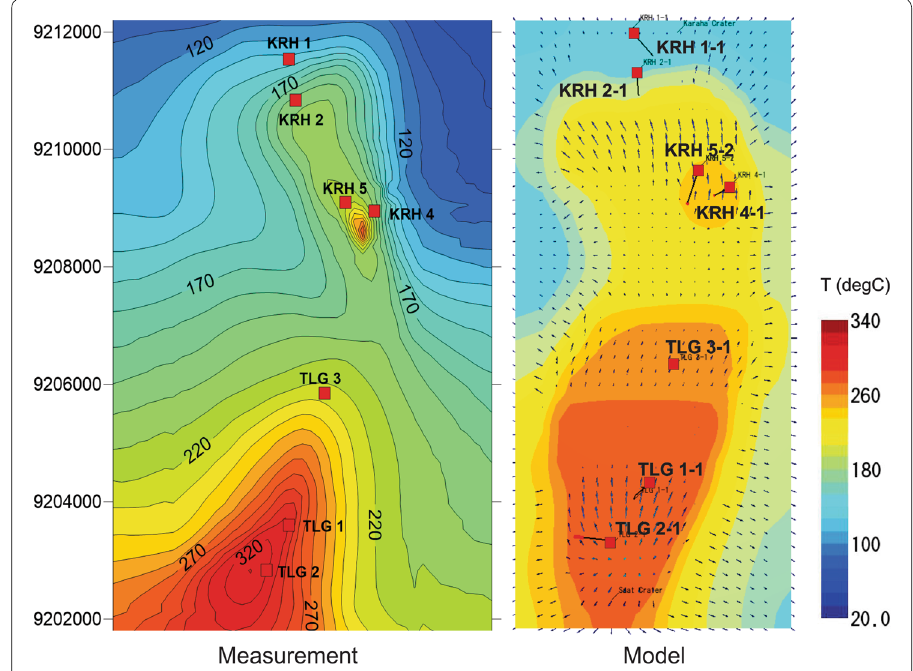
Fig. 12 Lateral temperature distribution comparison at sea level between a model and b measured